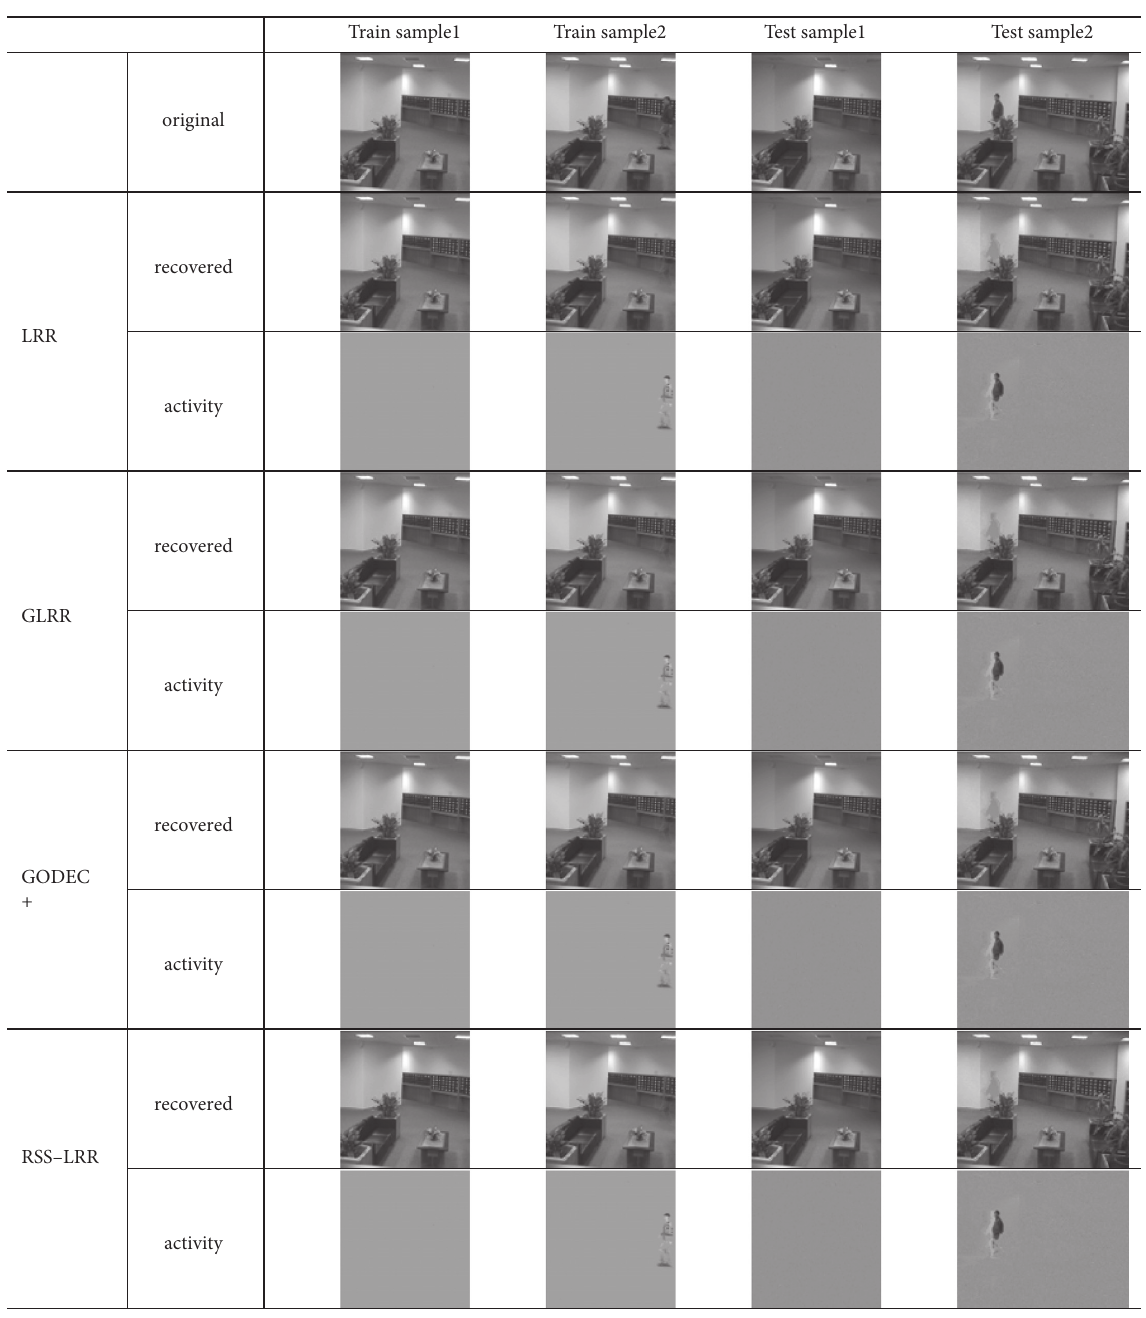
Figure 2: Results obtained by all algorithms on surveillance video. Table 1: Activity results of all algorithms on surveillance